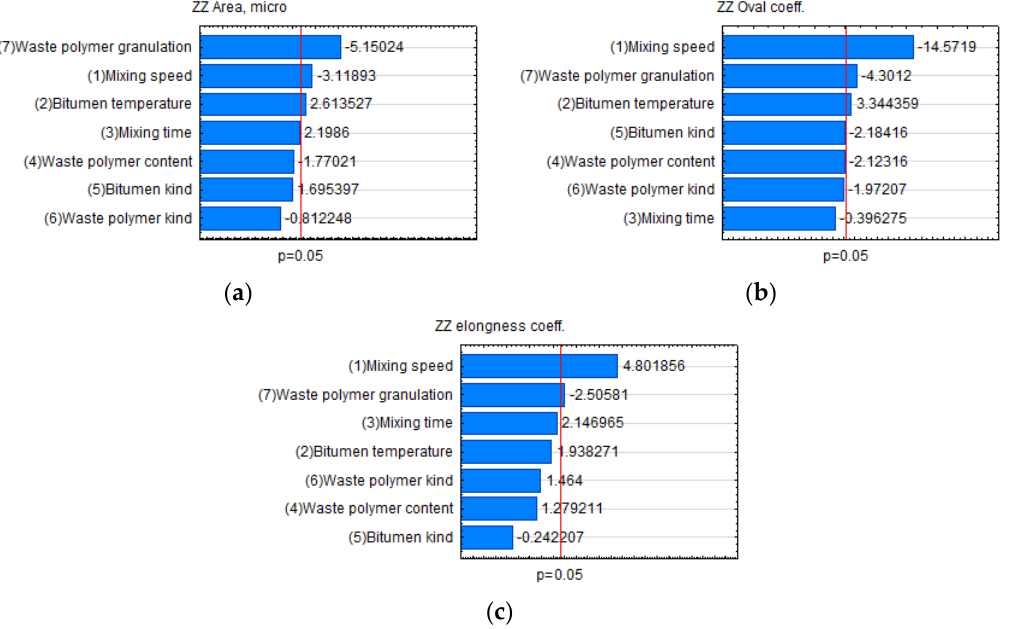
Figure 7. Quantitative analysis of the dispersion of plastomer particles in bitumen: ( a ) particle surface area; ( b ) roundness coefficient; ( c ) major diagonal.